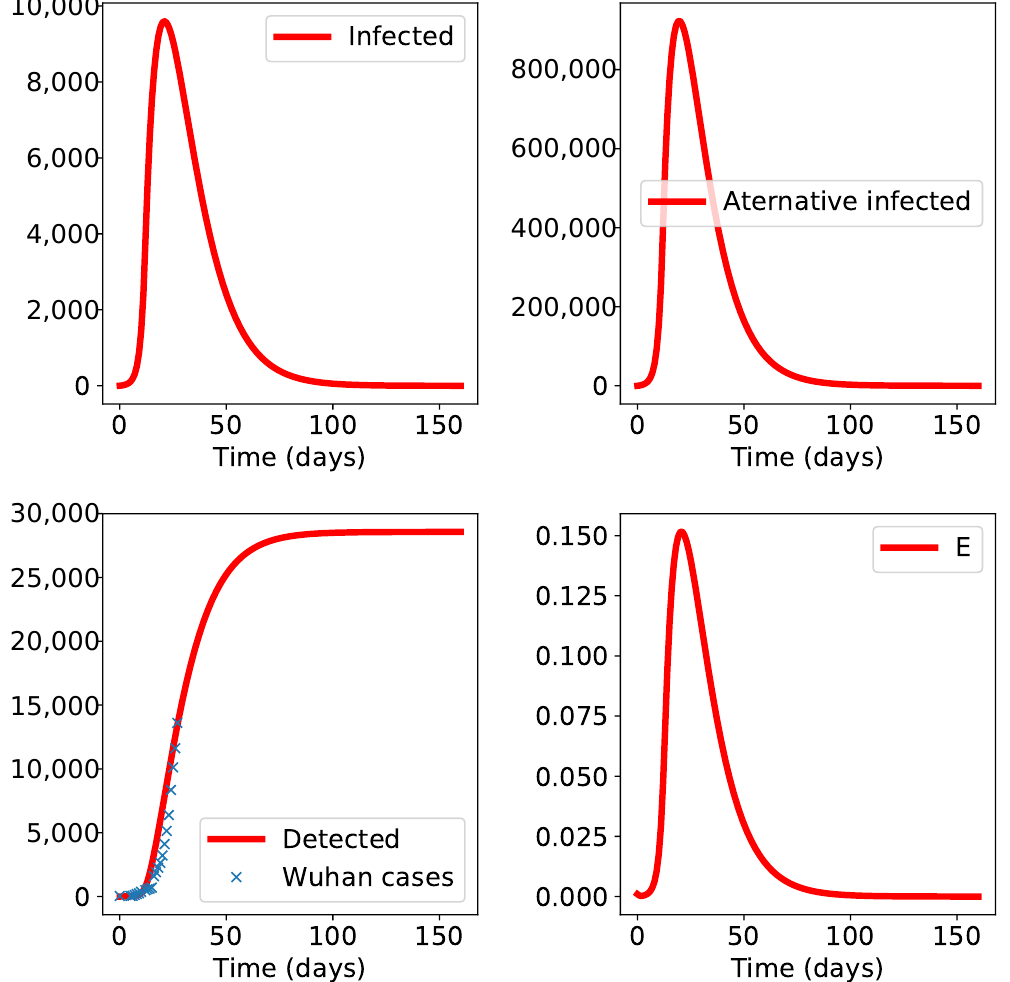
Figure 2. Results of the model for Wuhan city epidemic. The initial date t 0 is set to 11 January 2020 and the data available up to 9th February is used in this simulation. The class “E” is increasing which indicates important environmental propagation.